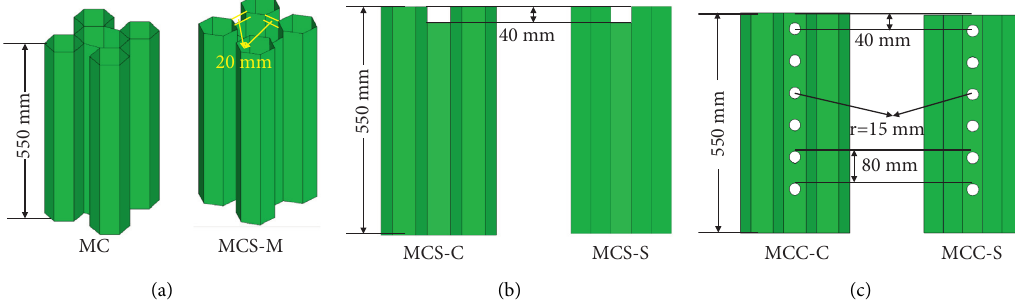
Figure 2: The windowed structures at different positions in the experimental study. (a) Multi-cell structure. (b) Square windowed structure. (c) Circular windowed structure.